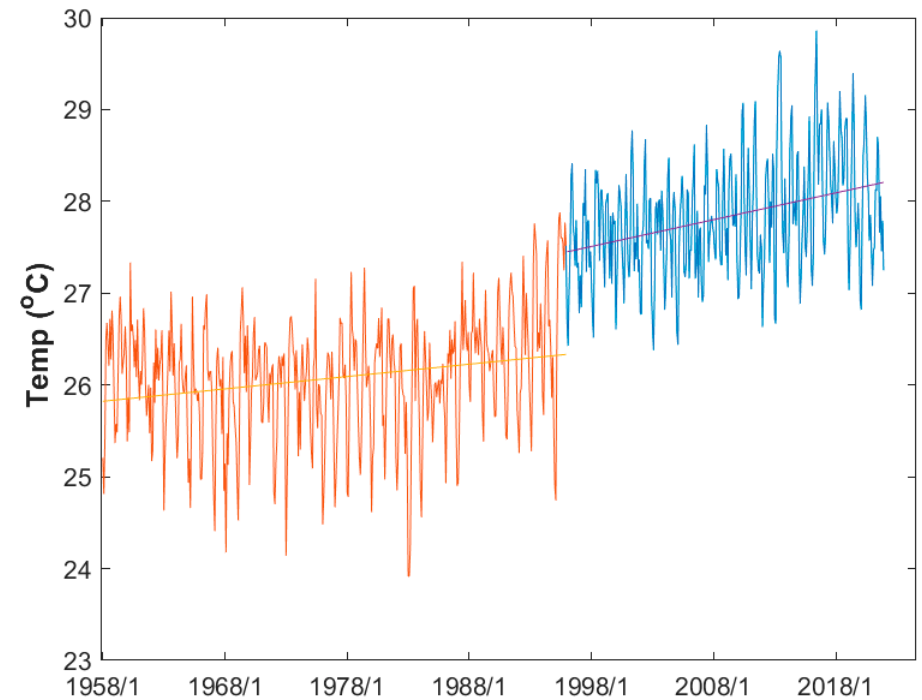
Figure 2. Change detection of monthly mean temperatures at Guam International Airport using Pet- titt’s test. Orange line represents monthly mean temperatures recorded by NOAA SWMO (1958–1995), and blue line denotes those by NOAA WFO (1996–current). A change point was detected in March 1995. Orange line shows the trend line for monthly temperatures for the 1958–1995 and purple line does for the 1996–current.